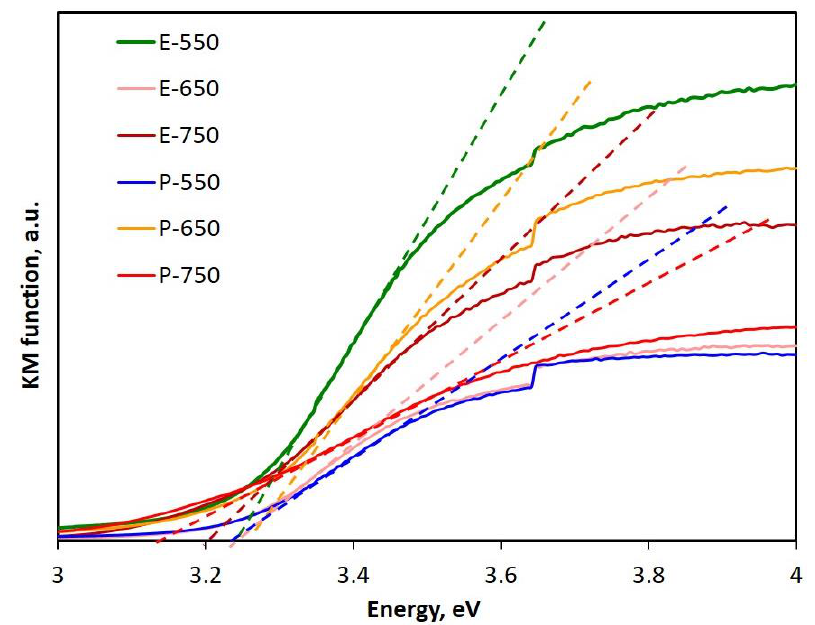
Figure 6. Deduction of band gap values from the Kubelka–Munk function (derived from the diffuse reflectance spectra of the samples).